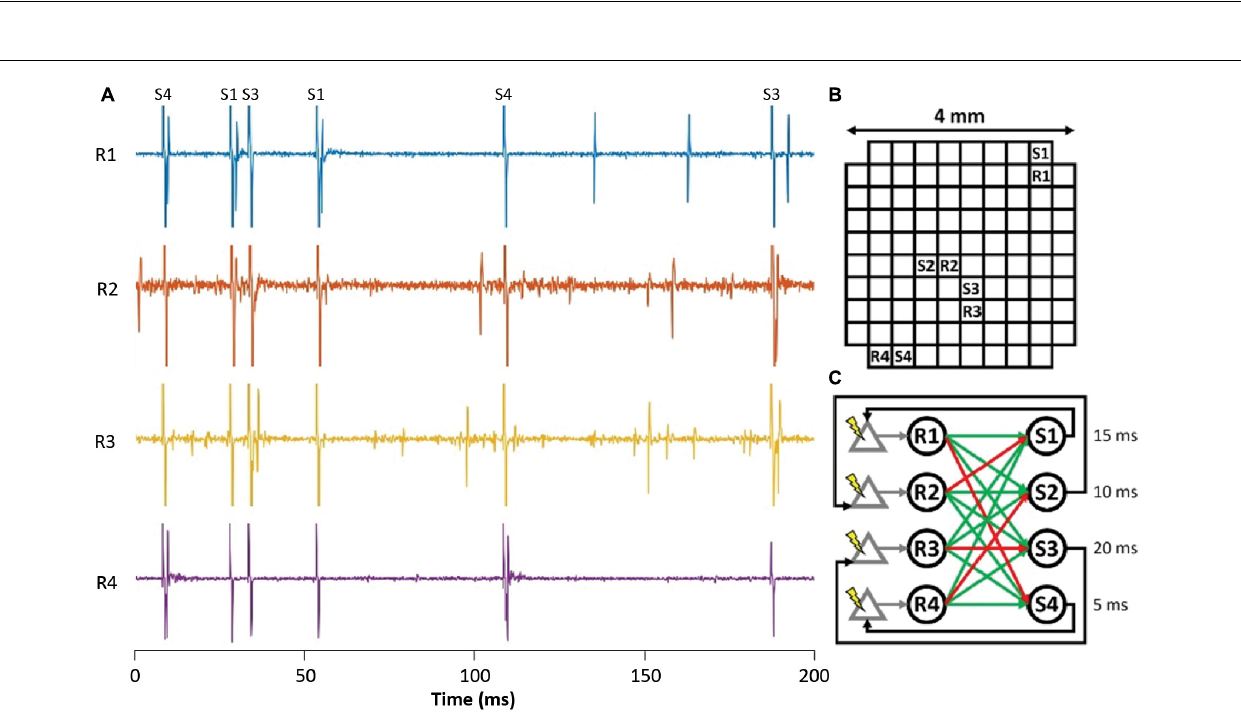
Frontiers in Neuroscience |